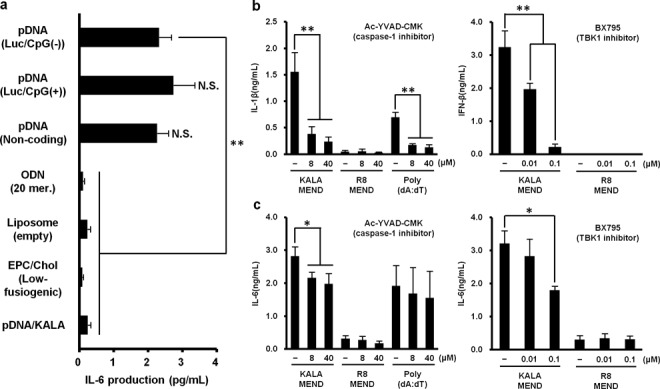
Molecular mechanism of the cytokine expression induced by KALA-MEND. (a) BMDCs (4.0 × 105 cells) were transfected with several types of KALA or R8 peptide-modified nanoparticles. (b,c) BMDCs (4.0 × 105 cells) were pre-treated with 0.01 or 0.1-μM solutions of BX795 or 8 or 40-μM solutions of Ac-YVAD-CMK for 30 min, then transfected with KALA- or R8-MEND (equivalent to 0.4-μg pDNA) or Poly (dA:dT) conjugated with Lipofectamine® 2000 reagent (0.4 μg:1.2 μl, only Ac-YVAD-CMK treatment). After 6 h, the concentrations of several cytokines in the supernatant were measured by ELISA. Data are mean ± SD of three independent experiments. Statistical analyses were performed by the one-way ANOVA, followed by Bonferroni test. *P < 0.05, **P < 0.01 versus no inhibition group. N.S.: not significant